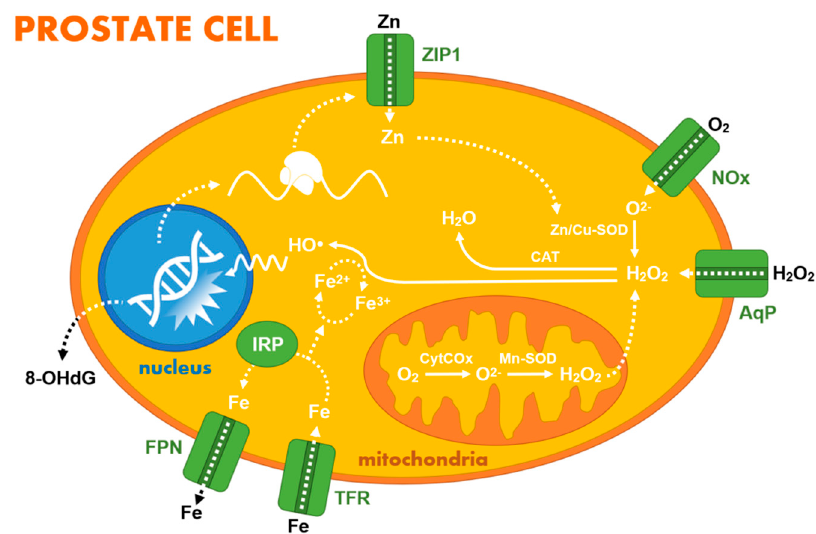
Figure 2. Molecules involved in oxidation stress within a prostate cell. Schematic presentation of a prostate cell (with nucleus and mitochondria as the only organelles) and ions/simple inorganic molecules involved in oxidation stress and possible DNA damage discussed in this review, as appearing prior to/during PCa progression. ZIP1—Zinc transporter, NOx—NADPH oxidase, AqP—Aqua- porin, TFR—Transferrin receptor, FPN—Ferroportin, IRP—iron-responsive element-binding pro-